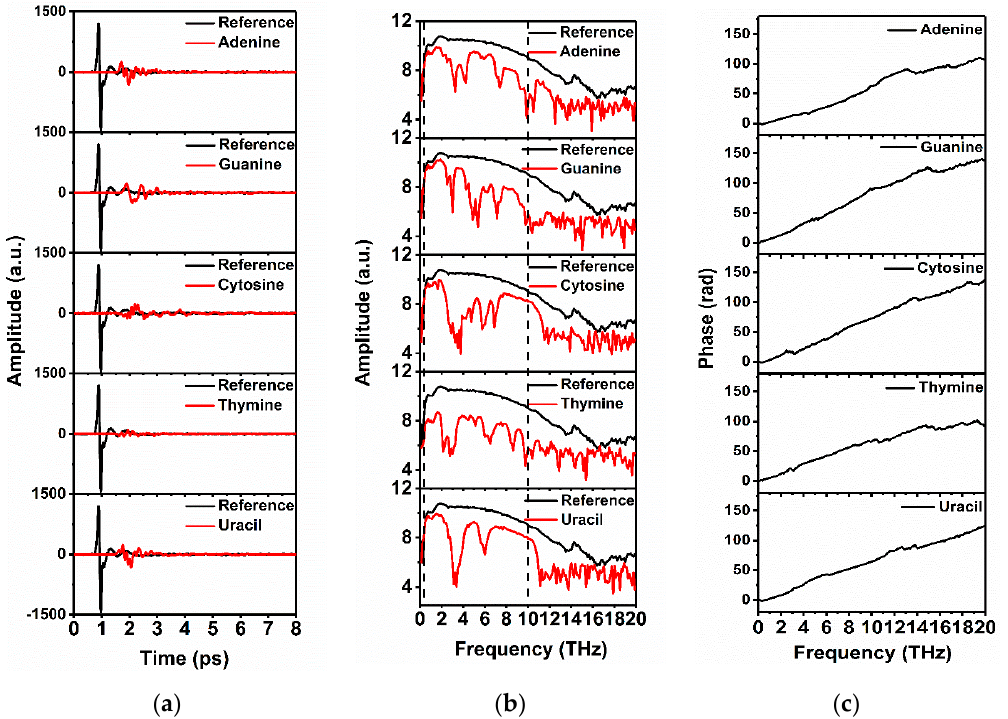
Figure 3. Waveforms of the nucleobases (50 mg) and the reference. ( a ) Time-domain spectra; ( b ) Fourier transform spectra; ( c ) The phase spectra.